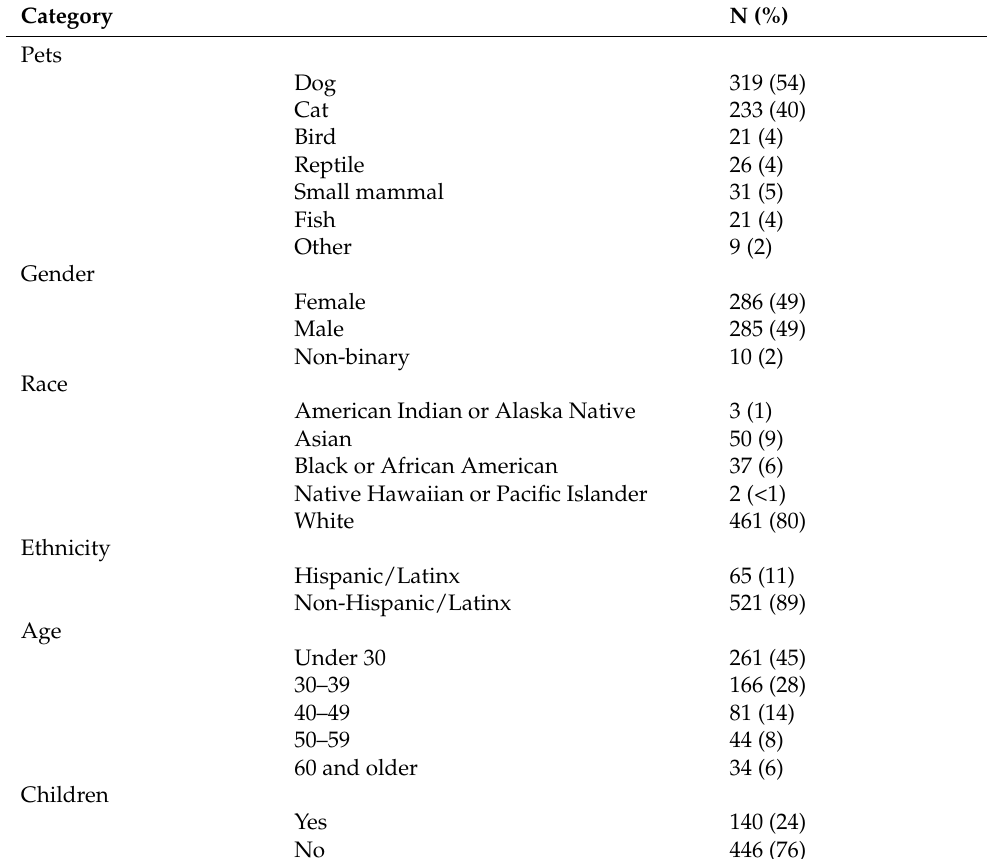
Table 1. Participant